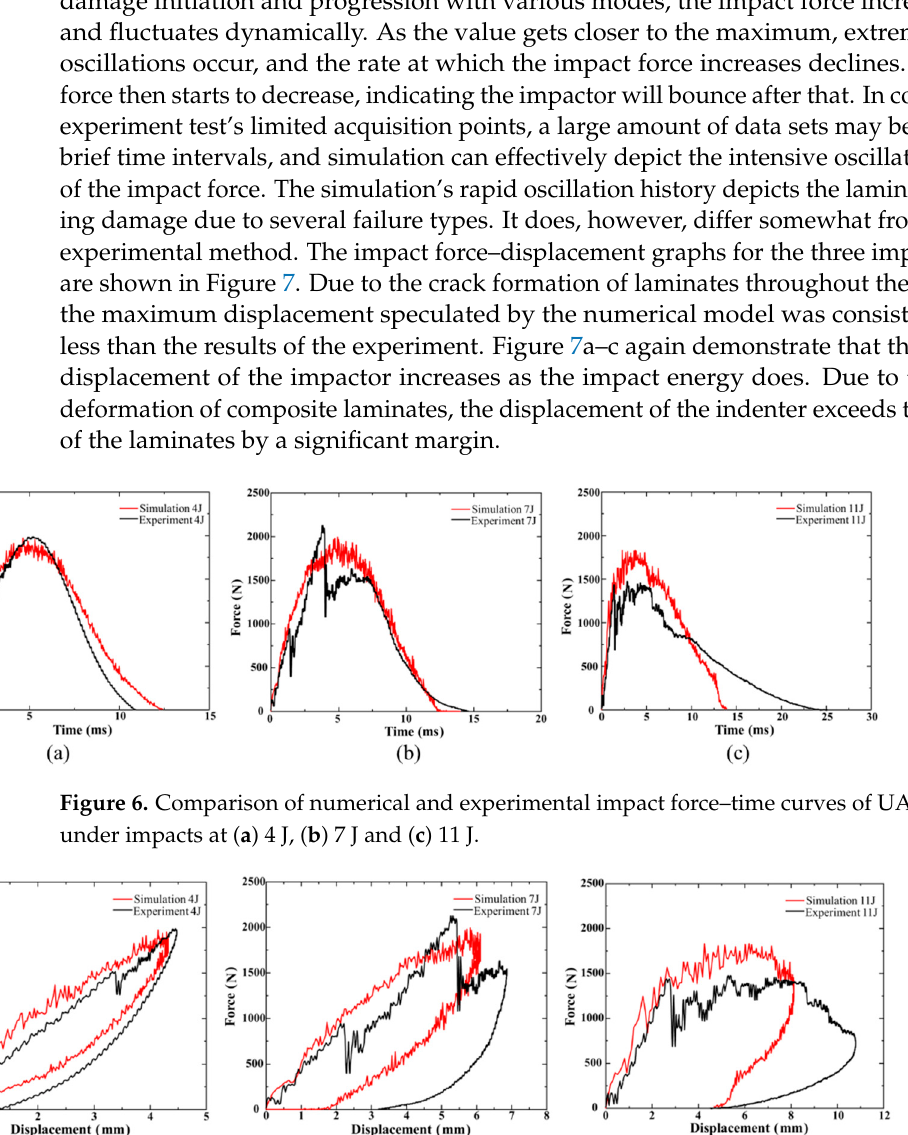
Figure 8. Comparison of numerical and experimental energy–time curves of UACS laminates under impacts ( a ) 4 J, ( b ) 7 J and ( c ) 11 J. 4.2. Post Impact C-Scan Inspection Additional information on the damage mechanisms is provided by the C-scan maps of UACS and continuous CFRP laminates (see Figure 9). The impact-damaged specimens are also compared to the C-scan maps. Each damaged UACS laminate is represented by